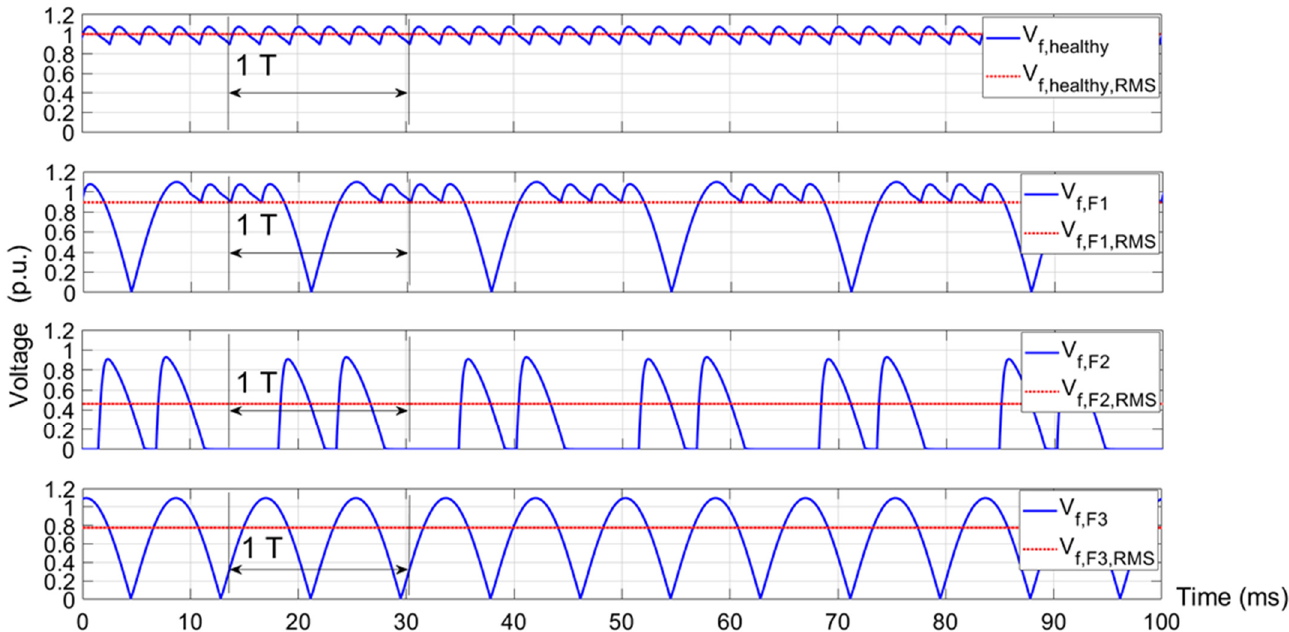
Figure 2. Main field voltage (V f ) waveform and r.m.s. value for healthy conditions and for faulty conditions (F1: open-diode fault; F2: shorted-diode fault; F3: open-phase fault).